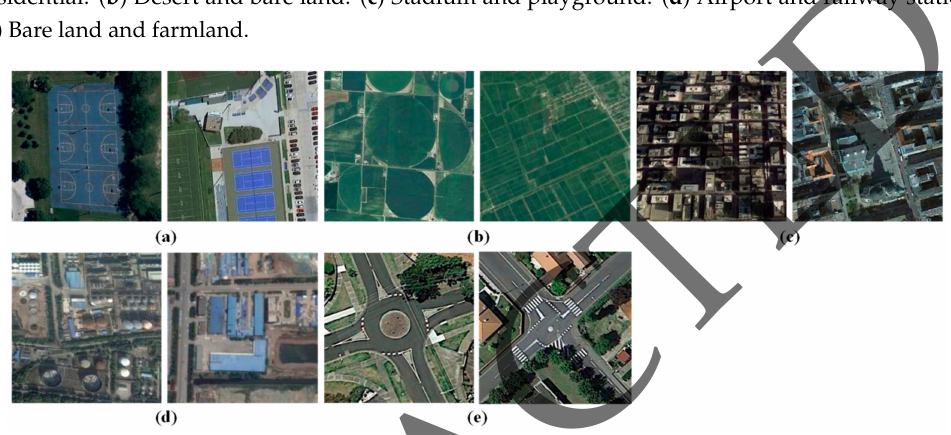
Figure 16. The major confusion of the ADFF approach in the NWPU-RESISC45 dataset. ( a ) Basketball court and tennis court. ( b ) Circular farmland and rectangular farmland. ( c ) Church and commercial area. ( d ) Storage tanks and industrial area. ( e ) Roundabout and